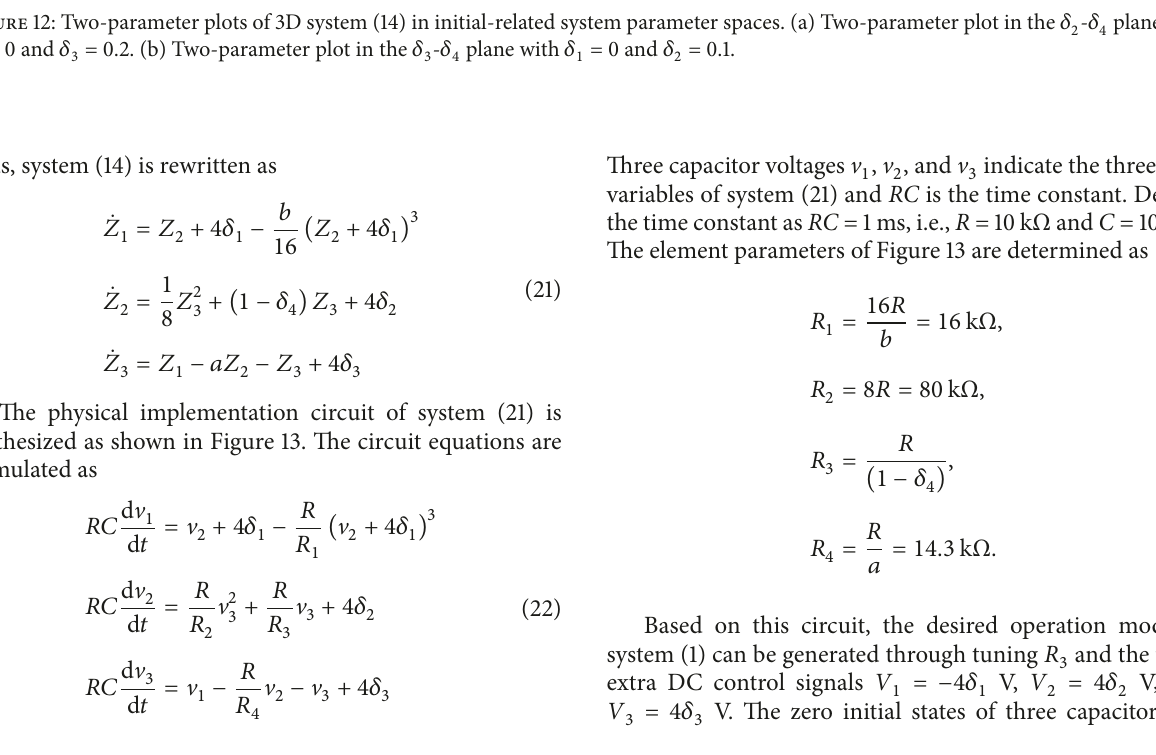
𝛿 𝛿 𝛿 𝛿 3 - 4 plane with 1 = 0 and 2 =